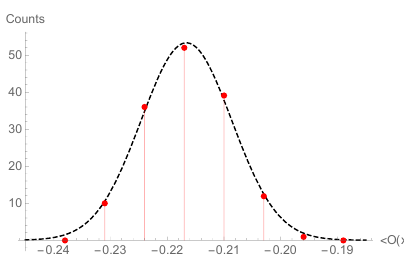
Figure 8 . Distribution of the value of the vev at the peak, h O i ( x = 0) , for (cid:22) V = 0 : 3 for 150 runs. We (cid:12)t this to a Gaussian, f ( x ) = A exp (cid:27) = 8 (cid:2) 10 (cid:0) 3